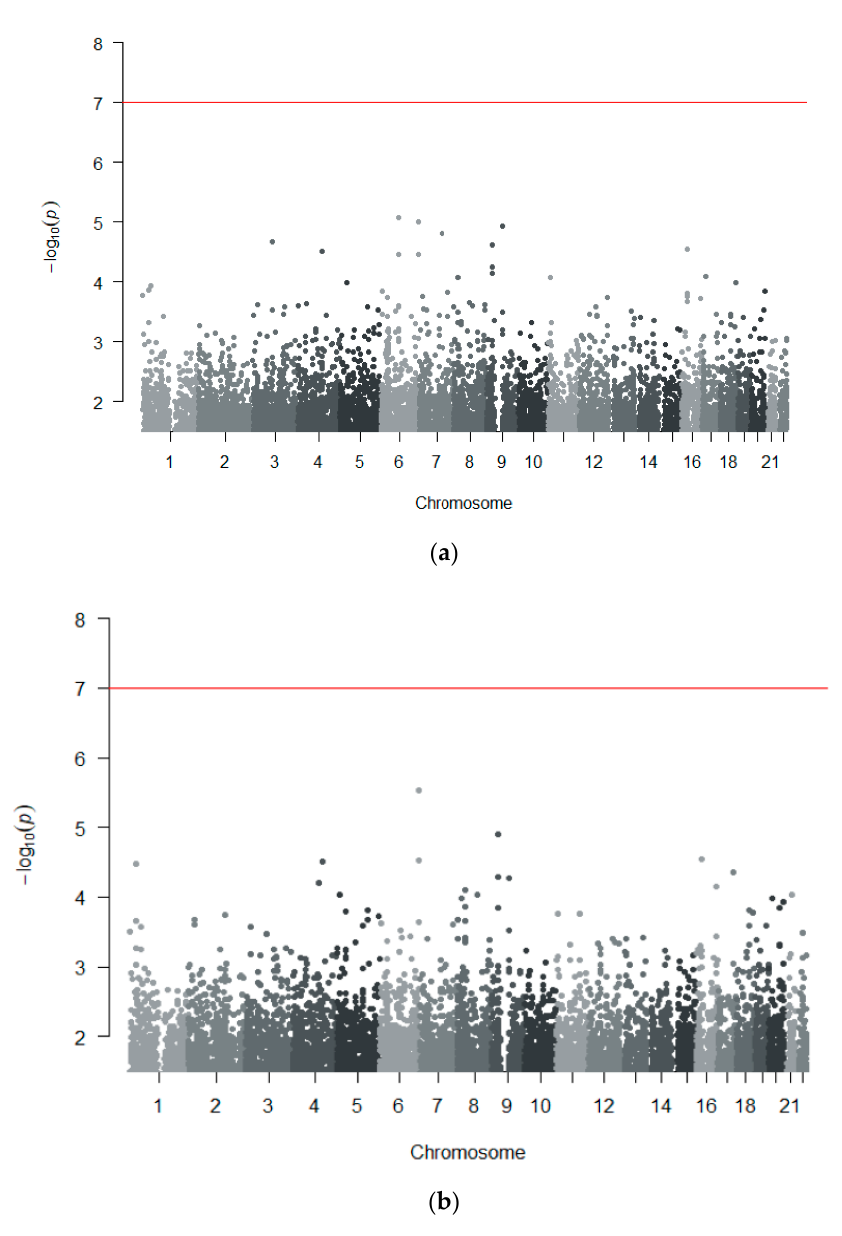
Figure 2. Manhattan plot of genome ‐ wide association analyses in the MIA/MIN ‐ CH cohort . Results from 304,704 genotyped SNPs after quality control are shown, adjusted by multidimensional scaling (MDS) dimensions 1 ‐ 4: ( a ) Analysis of all 45 cases (MIA and MIN) versus 191 controls (tolerant and unexposed combined). The top SNP was rs191786, located in an intergenic region nearest to the TENT5A gene on chromosome 6; ( b ) Analysis of 30 MIA cases versus 191 tolerant/unexposed controls. The top SNP was rs9366076, located in an intergenic region nearest to the RNASET2 gene on chromosome 6. The red line shows the threshold for genome ‐ wide significance of 1 × 10 − 7 .